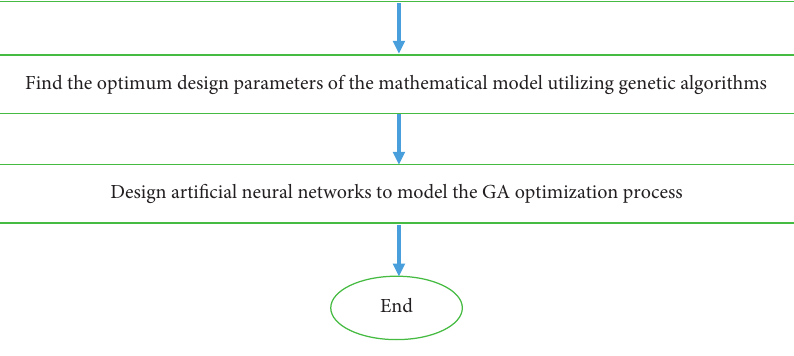
Figure 1: Flowchart of the proposed methodology.